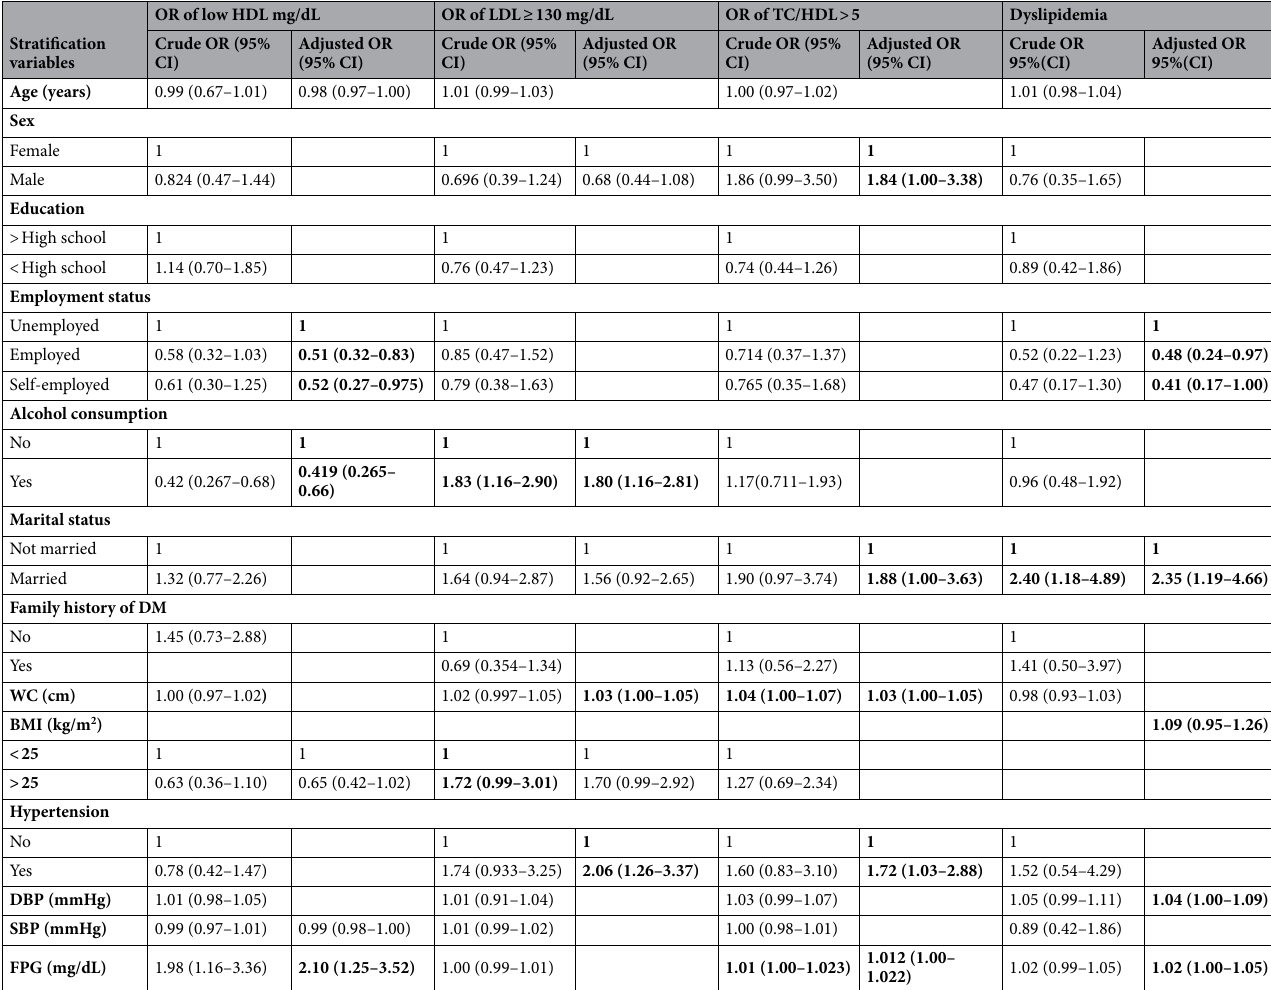
Table 5. Association between LDL, TC, TG, HDL, Non-HDL and TG/GDL ratio with key risk factors: result from logistic models. Significant values are in bold. TG triacylglycerol, TC total cholesterol, HDL-C high- density lipoprotein cholesterol, LDL-C low-density lipoprotein